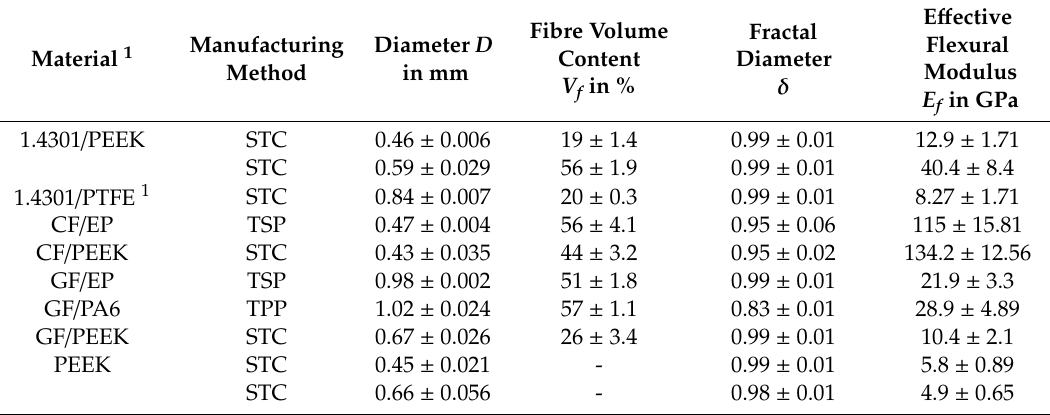
Table 4. Manufacturing method and material properties of the investigated miniaturised rod-shaped wire reinforced and fibre reinforced polymers (mean value ± standard deviation).